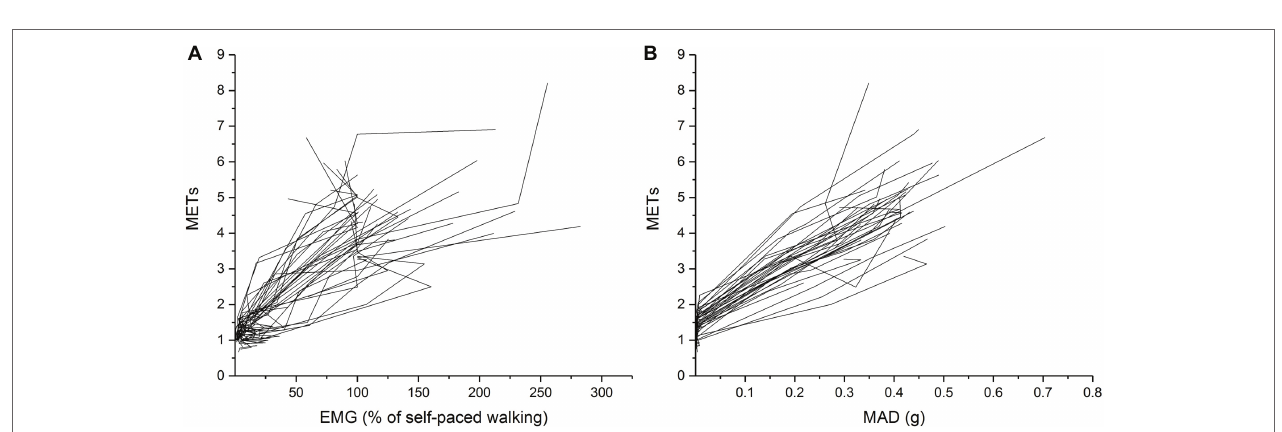
FIGURE 3 | Individual MAD (A) and EMG (B) plotted against METs during all activities. The activities included lying down, sitting quietly, sitting while playing mobile game, standing quietly, standing while playing mobile game, walking on a treadmill at 4 and 6 km/h, and self-paced